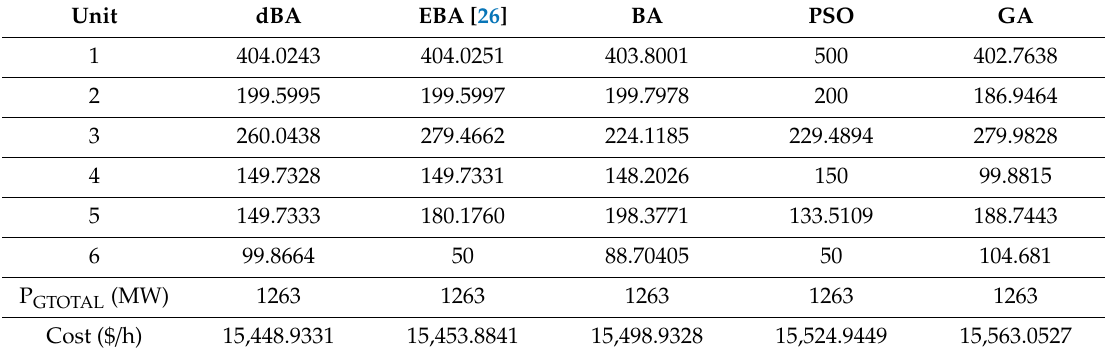
Table 19. Comparison of the dBA, enhanced bat algorithm (EBA), BA, PSO, and GA without renewables.